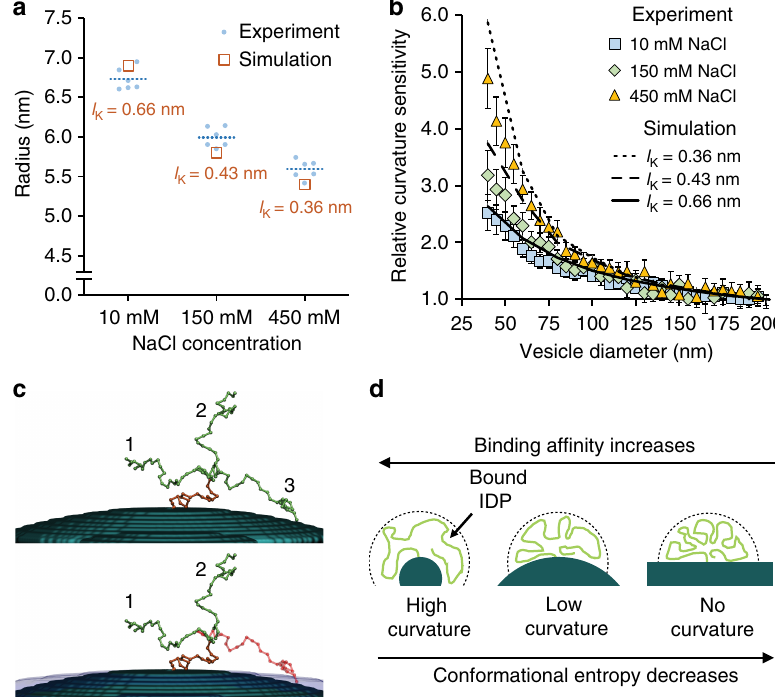
Fig. 3 Curvature sensing arises from IDP conformational entropy. a Comparison of experimentally measured and simulated change in protein radius as a function of salt concentration. Dashed lines represent the average value of six experimental replicates. b Comparison of experimentally measured and simulated curvature sensitivity as a function of salt concentration, Kuhn length, l K . Relative sensitivities are normalized to 200 nm SUVs for both experiment and simulation. All sensitivities were compared at concentrations that gave an average membrane coverage of approximately 3%. The concentrations of protein in solution required to achieve this level of membrane coverage was 5 nM for the 10 and 150 mM NaCl conditions, and 10 nM for the 450 mM NaCl condition. Error bars are the 95% con fi dence interval of the mean. Each bin contains N = 36 – 249 data points acquired cumulatively from three independent replicates. c Simulated surface with representative IDP conformations. (Top) The orange segment represents the fi rst 20 monomer units within the polymer. The con fi guration of this segment was chosen in previous steps of the simulation and is fi xed in all subsequent steps. Three of the 10,000 + segment conformations generated for the remainder of the polymer chain are shown in green. (Bottom) When radius of curvature for the surface is increased, one of the three conformations becomes unallowable (red). d Schematic of proposed entropy-driven curving sensing mechanism for